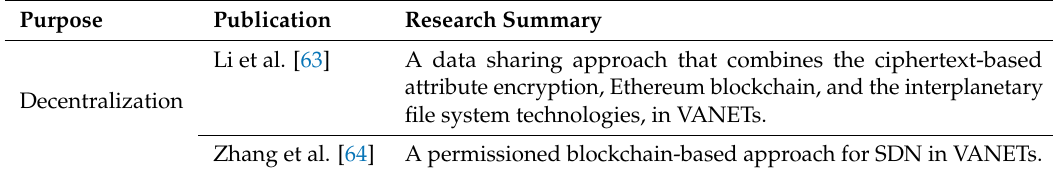
Table 3. Blockchain for networking layer issues in vehicular